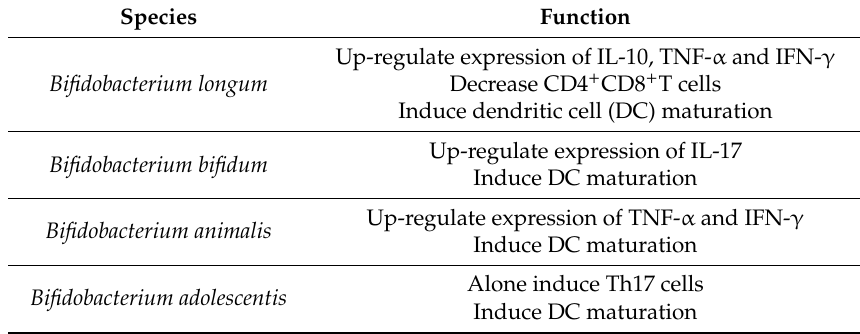
Table 1. The function of different species Bifidobacterium strains in human immune system maturation.